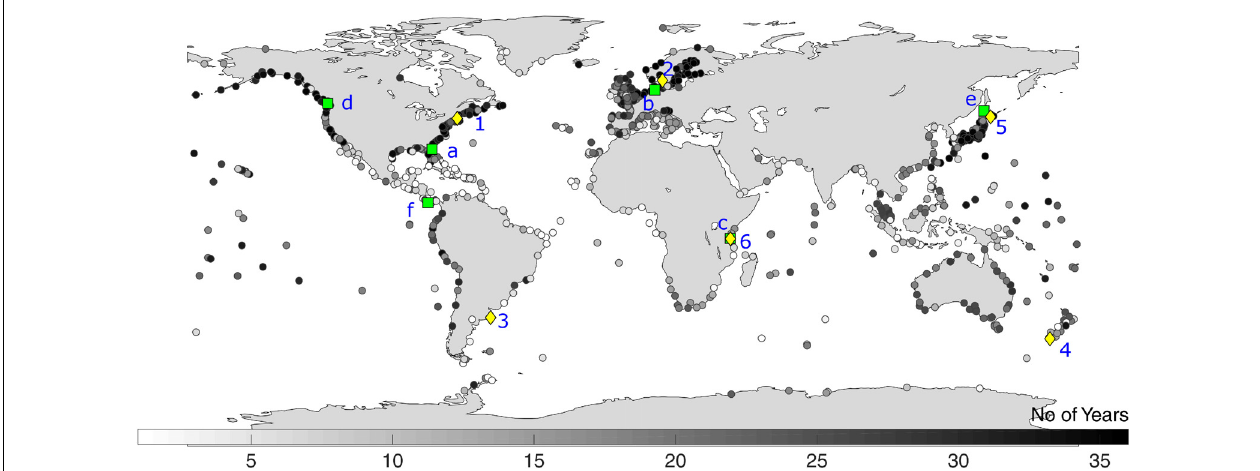
FIGURE 1 | Number of years available for analysis during the 1979–2014 period. Green squares and yellow diamonds represent two sets of tide gages used in section “Results” to assess model performance in more detail: (a) St. Augustine, (b) Cuxhaven, (c, 6) Zanzibar (d) Victoria Harbor, (e) Wakkanai (f), Puerto Armuelles,